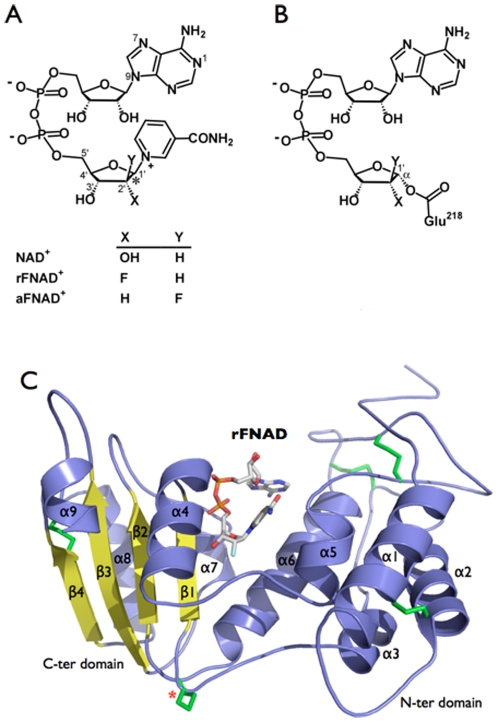
Chemical structure of rFNAD and aFNAD and their corresponding covalent intermediates with Glu218.The 2′-fluorinated analogs of NAD+ (A) are slow substrates of bCD38 that can covalently react with the catalytic residue Glu218 (B). The asterisk designates C1′ of the furanoside ring that forms the covalent bond with the carboxylate group of Glu218. The standard numbering is indicated. (C) Overview of the structure of the Michaelis complex with rFNAD. The ligand is shown non-covalently bound in the active site of the bCD38 E218Q mutant.